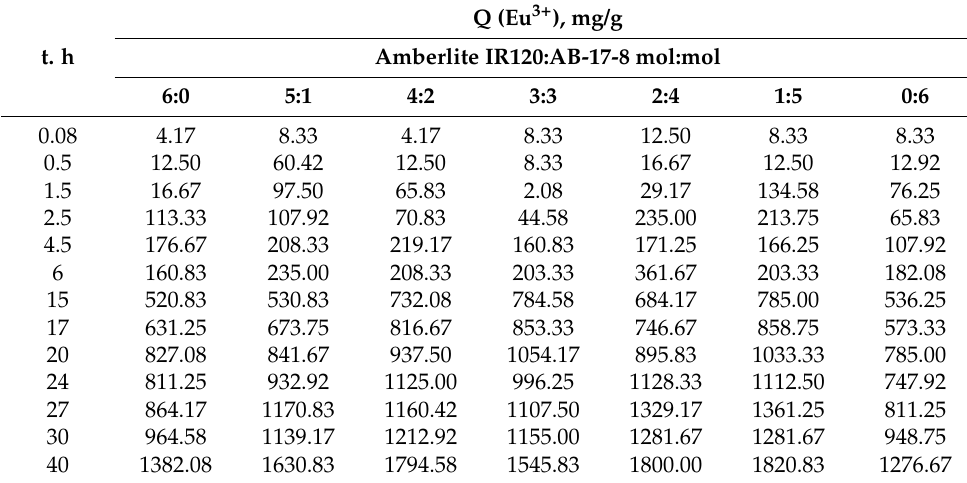
Table 3. Effective dynamic exchange